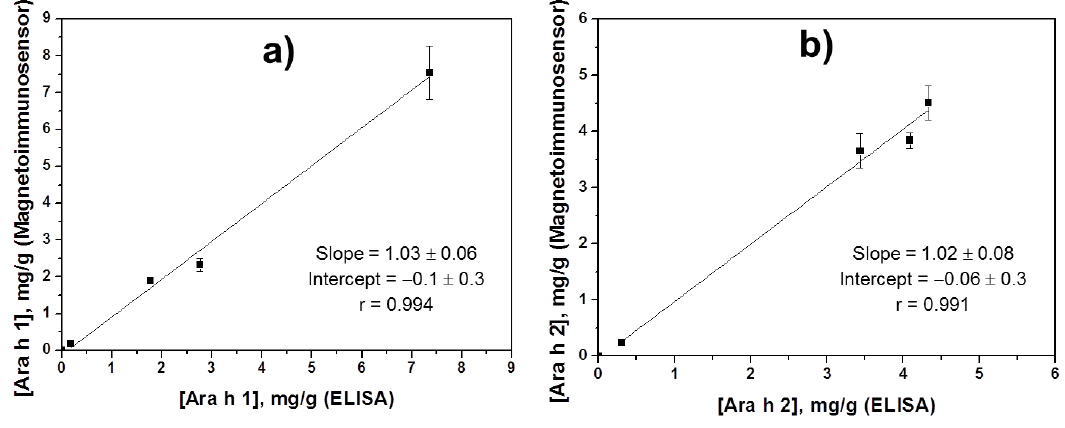
Figure 5. Correlation plots between the results obtained in the determination of Ara h 1 ( a ) and Ara h 2 ( b ) in food extracts using the developed dual immunoplatform and those provided by the individual ELISA spectrophotometric kits (data from Table 2). Table 2. Determination of the endogenous content of allergenic proteins Ara h 1 and Ara h 2 in different food extracts with the amperometric dual immunosensor and comparison with the results provided by ELISA spectrophotometric kits.